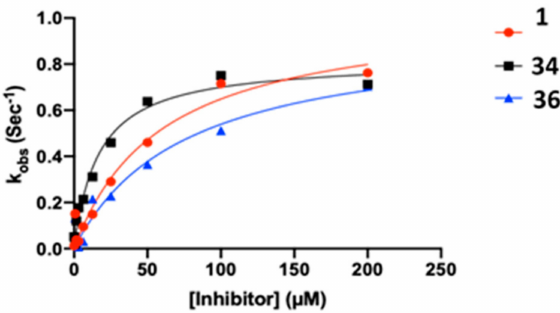
Figure 5. Inactivation kinetics for FMK analogs. k inact / K I plots for UCHL1 treated with 1 , 34 , and 36